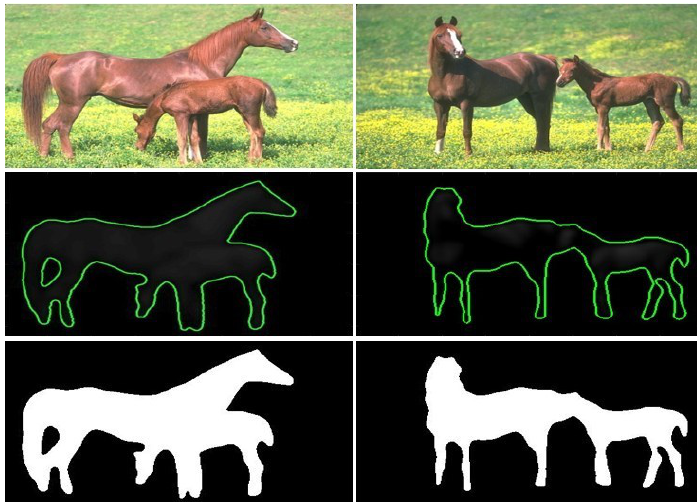
Figure 1. Illustration of our proposed algorithm. The 1st row contains the original input images, the 2nd row shows the detection of the object boundary during curve initialization and the 3rd represents the salience of the object.